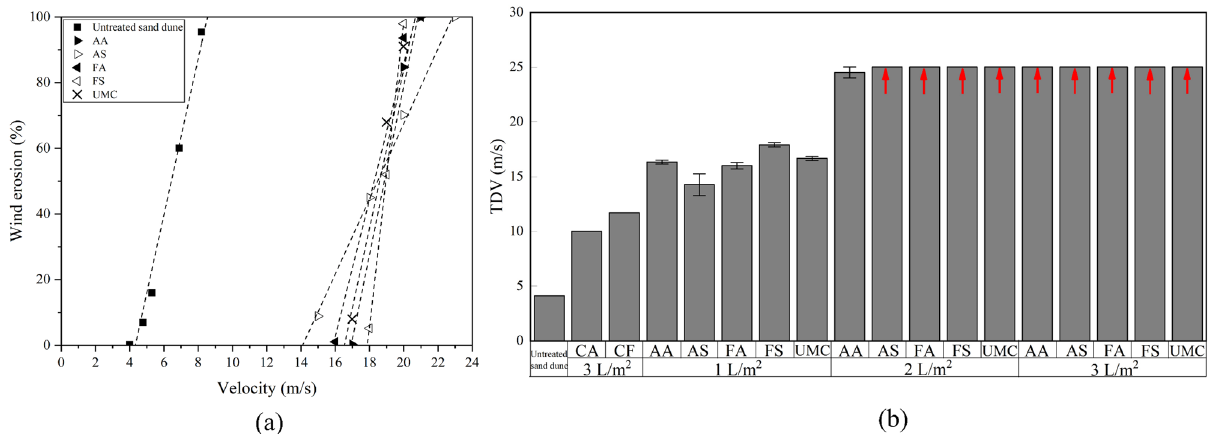
Figure 9. Wind erosion tests ( a ) weight loss versus wind velocity (application rate of 1 L/m 2 ), ( b ) threshold detachment velocity versus application rate and compositions (CA stands for calcium acetate, and CF for calcium formate).